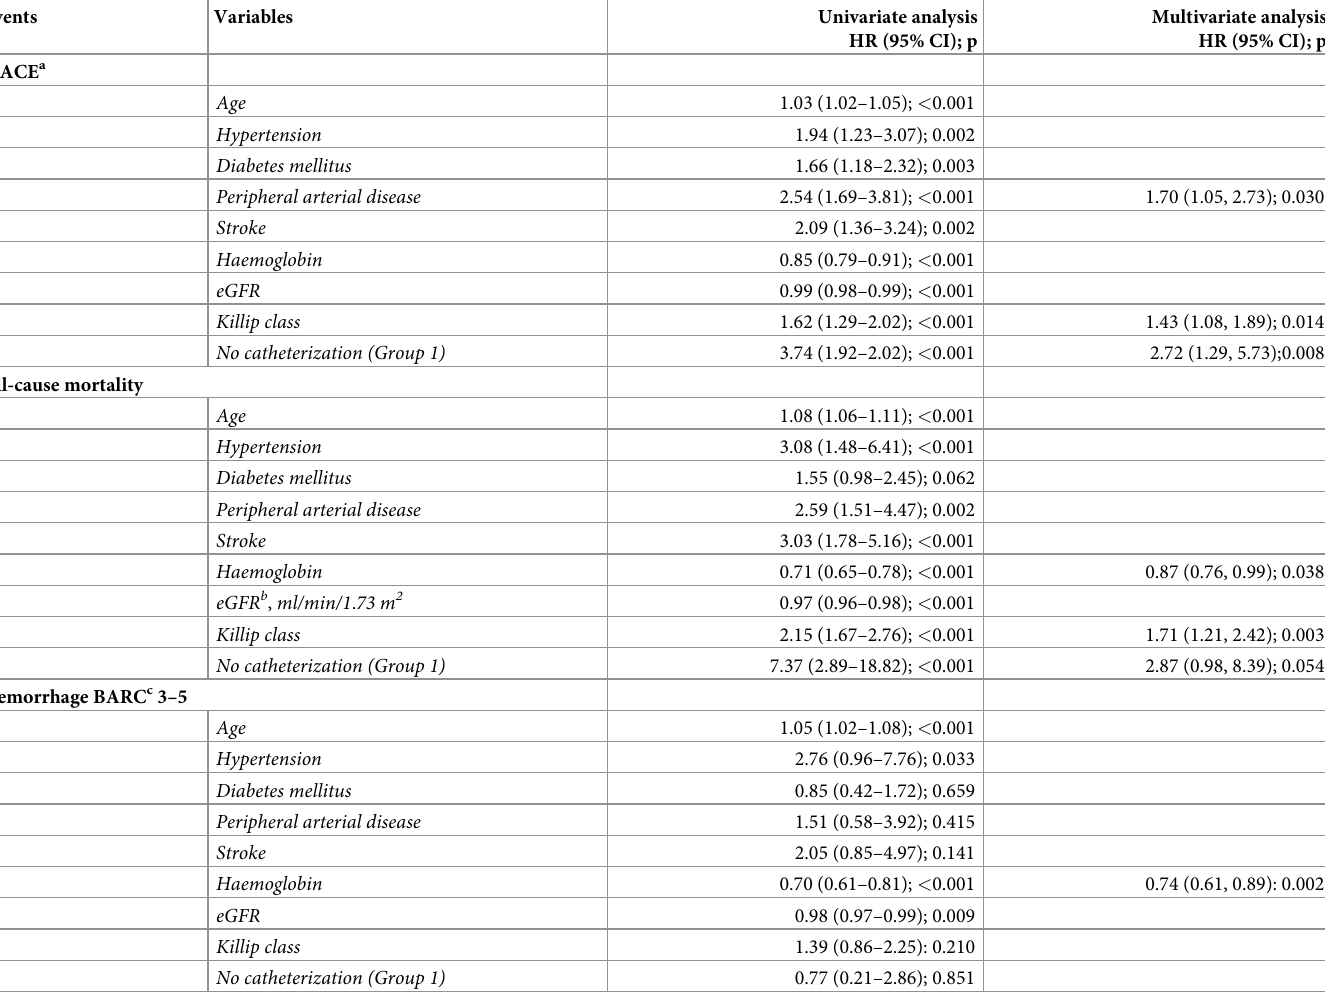
MACE a : cardiovascular death, stroke and acute nonfatal myocardial infarction; eGFR b : estimated glomerular filtration rate; BARC c : Bleeding Academic Research